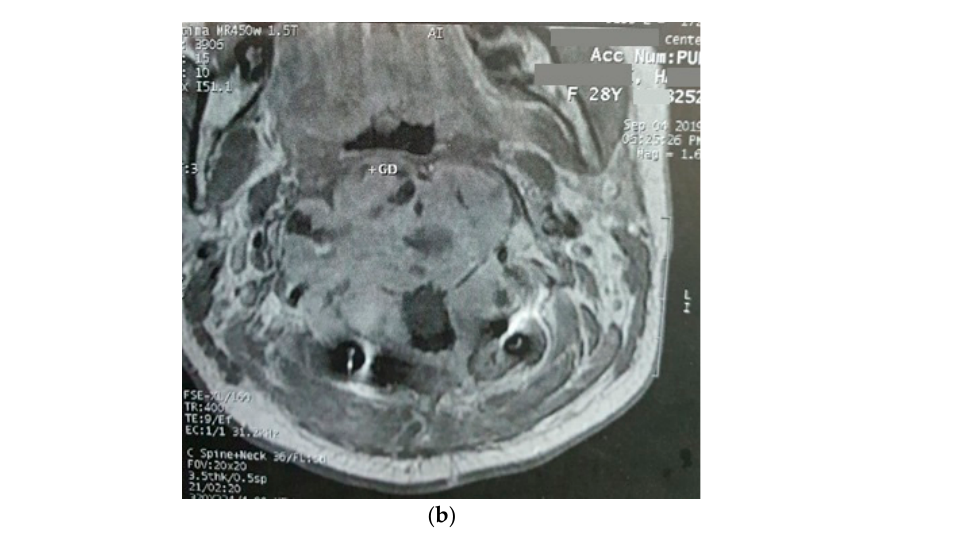
Figure 2. Sagittal ( a ) and axial ( b ) gadolinium-enhanced MRI after the progression of the tumor that caused severe dysphagia. Brain Sci. 2022 , 12 , x FOR PEER REVIEW